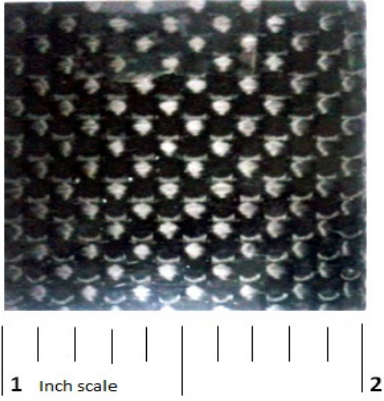
Figure 4. Composite specimen used for ablation tests.